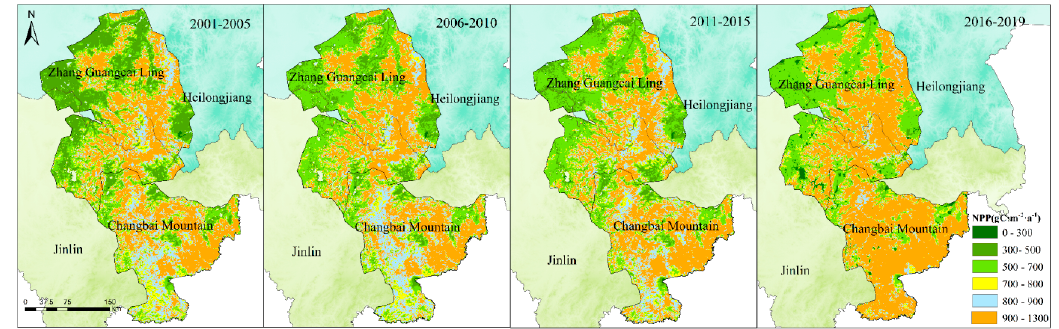
Figure 8. Spatial distribution of NPP in Northeast China, during different periods.